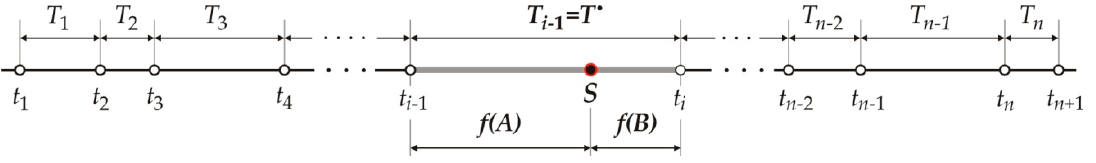
Figure 1. Stream of the independent events t i , intervals T i , and the independent choice of an interval